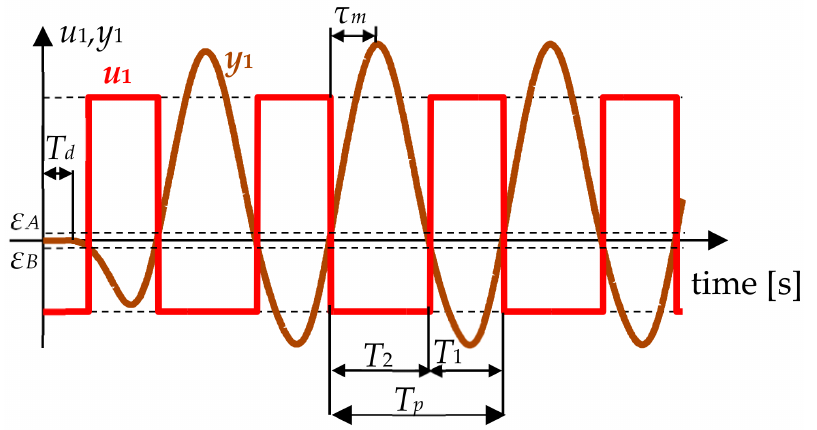
Figure 3. Time courses of the manipulated variable u 1 and the controlled variable y 1 under relay